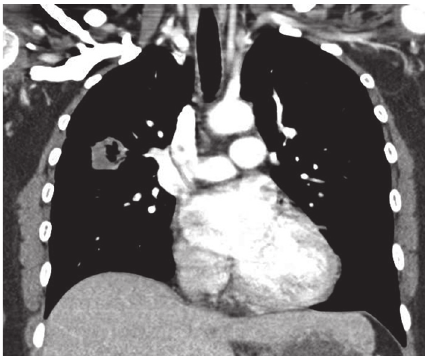
Figure 1: CT thorax showing the cavitary lesion in the right upper lobe of the lung.